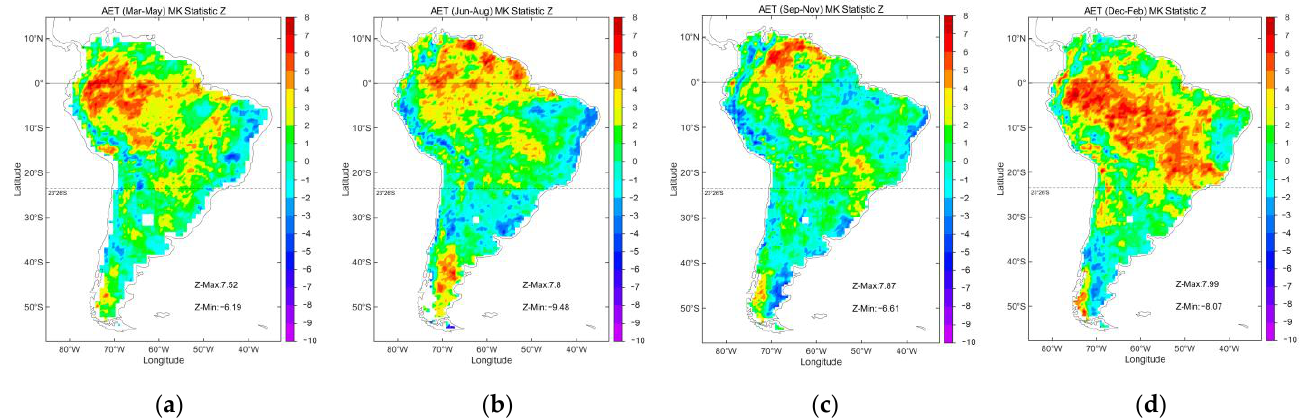
Figure 6. Spatial distribution map of MK statistic Z in four seasons. ( a ) Mar-May, ( b ) Jun-Aug, ( c ) Sep-Nov, ( d ) Dec-Feb.